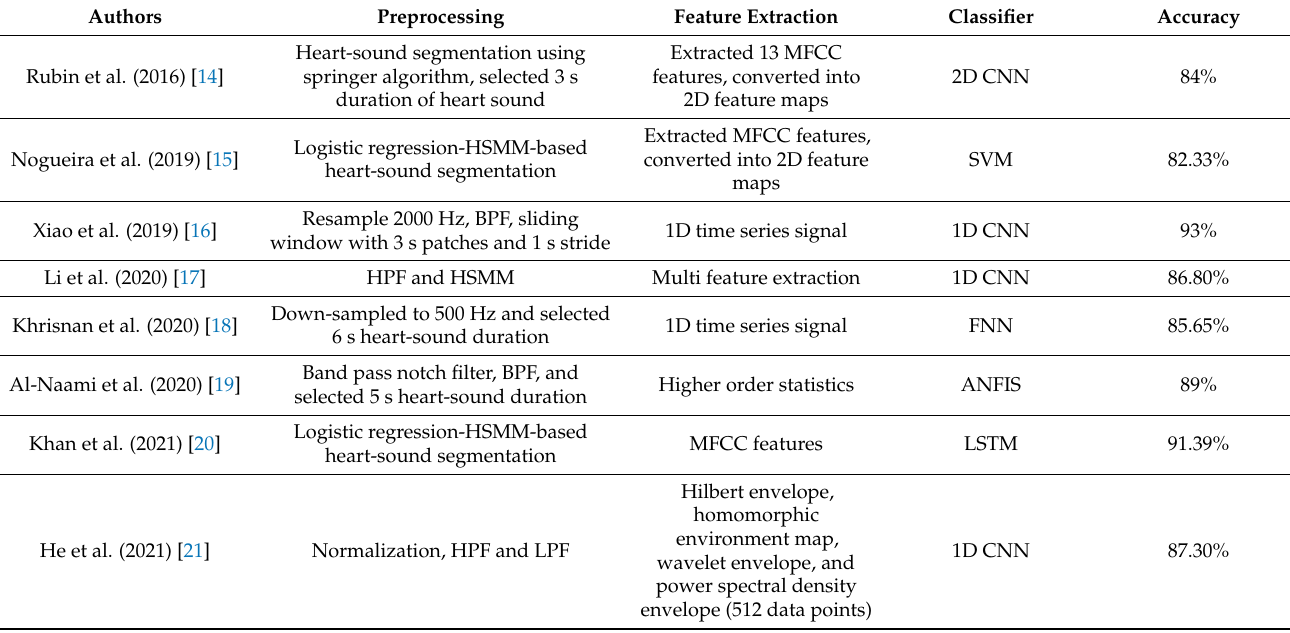
Table 2. Performance comparison with previous studies.